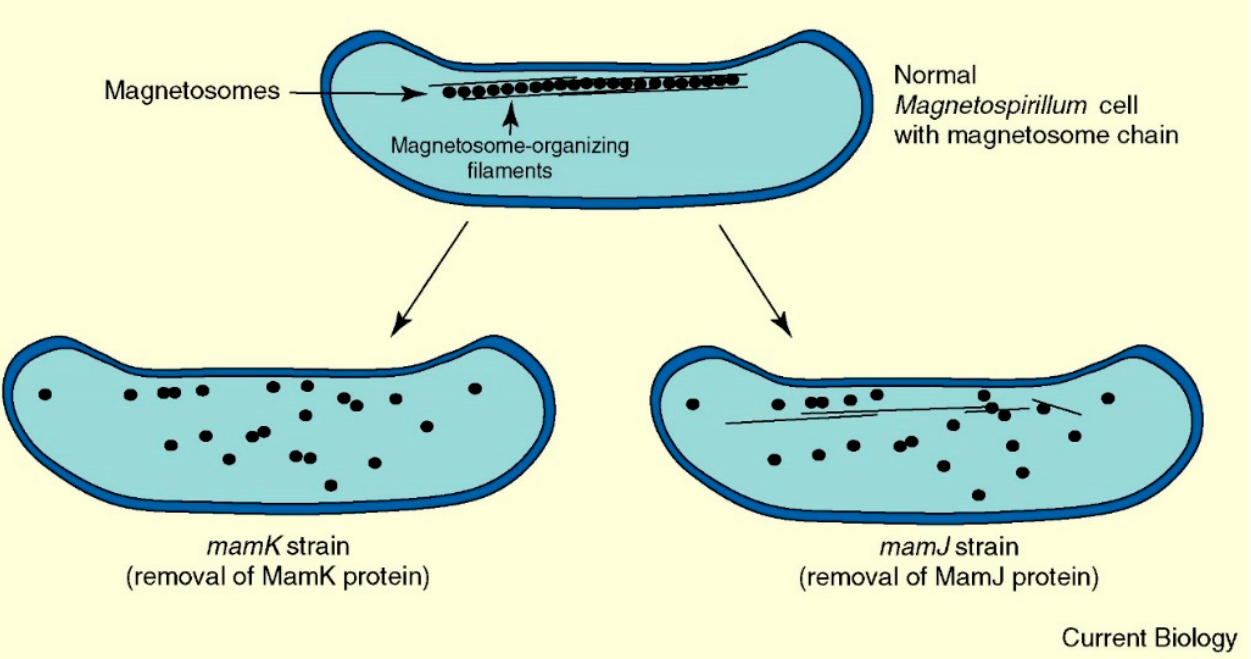
Figure 5. Cellular organization of bacterial magnetosomes. Reprinted from [70] copyright 2006, with permission from Elsevier.